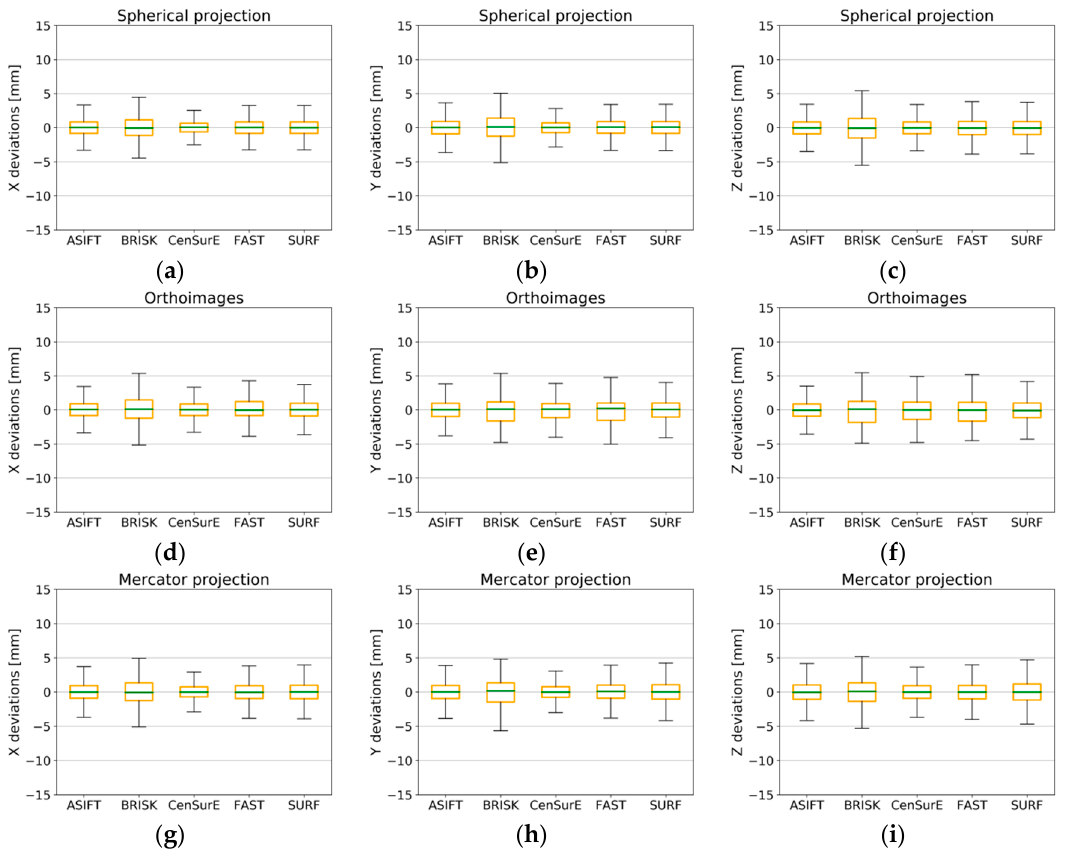
Figure 16. Box plots for the distribution of deviations of natural control points for all pairs of fully registered scans (without points used for the ICP and non-registration) for Test Site II. The spherical projection: component—x ( a ), y ( b ), and z ( c ); orthoimages: component—x ( d ), y ( e ), and z ( f ); the Mercator projection: component—x ( g ), y ( h ), and z ( i ).